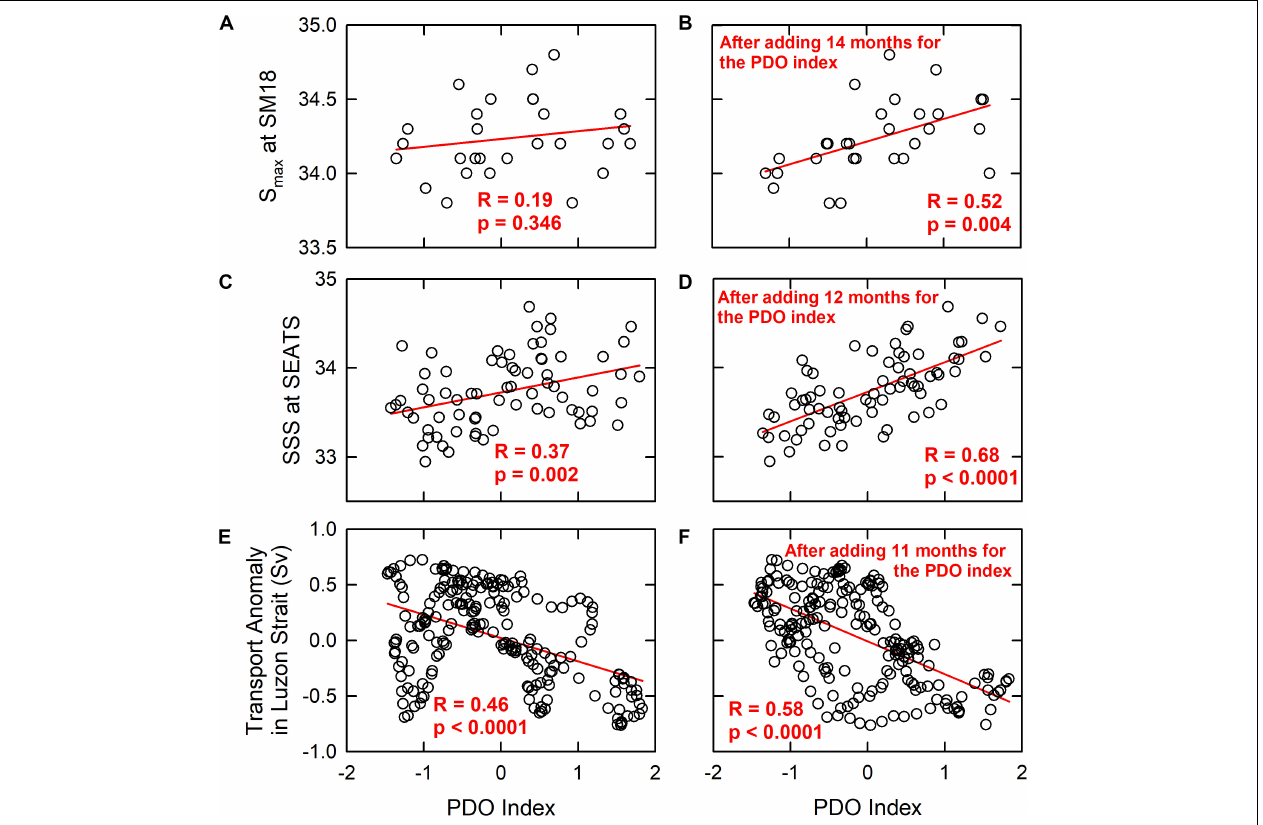
FIGURE 10 | (A,C,E) The S max at SM18, the SSS at SEATS and the transport anomaly in the Luzon Strait vs. the PDO index. (B,D,F) The best fitted correlations (the correlation coefficient, R, reaches the highest value) when the time series of S max at SM18, the SSS at SEATS, and the transport anomaly in the Luzon Strait are ahead by 14, 12, and 11 months, respectively. The red lines show the linear regression, and the numbers refer to the R - and p -values of the regression.